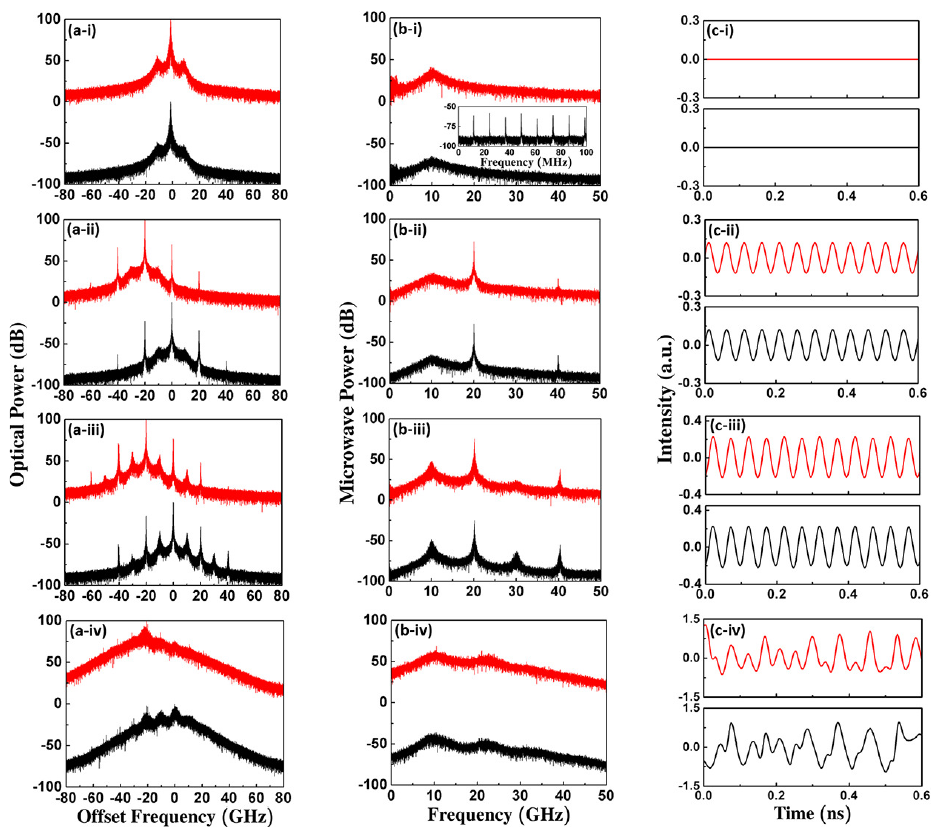
Figure 2. ( a ) Optical spectra, ( b ) microwave spectra, and ( c ) temporal evolutions of LD1 (red curve) and LD2 (black curve) for ( i ) mutual injection locking at ( ξ s at ( ξ s , f i ) = (0.011, − 20 GHz), ( iii ) P2 dynamics at ( ξ s 12 ( ξ s , f i ) = (0.05, − 20 GHz). The inset of ( b-i ) shows the enlargement of the microwave spectrum for 12 LD2 around 0 GHz. The x -axes in ( a ) are relative to the free-running oscillation frequency of LD2. The red curves in ( a , b ) are up-shifted by 100 dB for clear